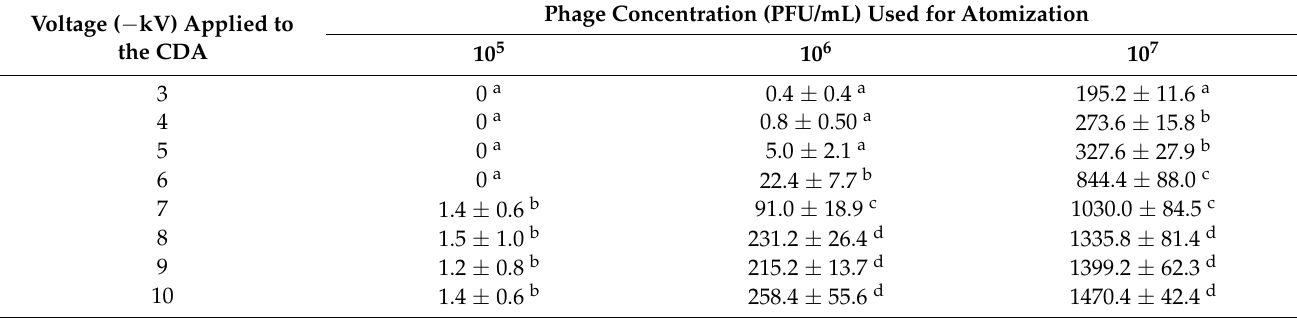
I Sample solutions with different phage concentrations were separately atomised toward the CDA for 1 min, then an aliquot of the grounded water of the CDA was collected to determine the concentration of the phages trapped in the water by the double-layered agar method. The means and standard deviations were calculated from five repetitions of the experiments. The letters (a–d) on the means in each vertical column indicate significant differences ( p < 0.05) according to Tukey’s